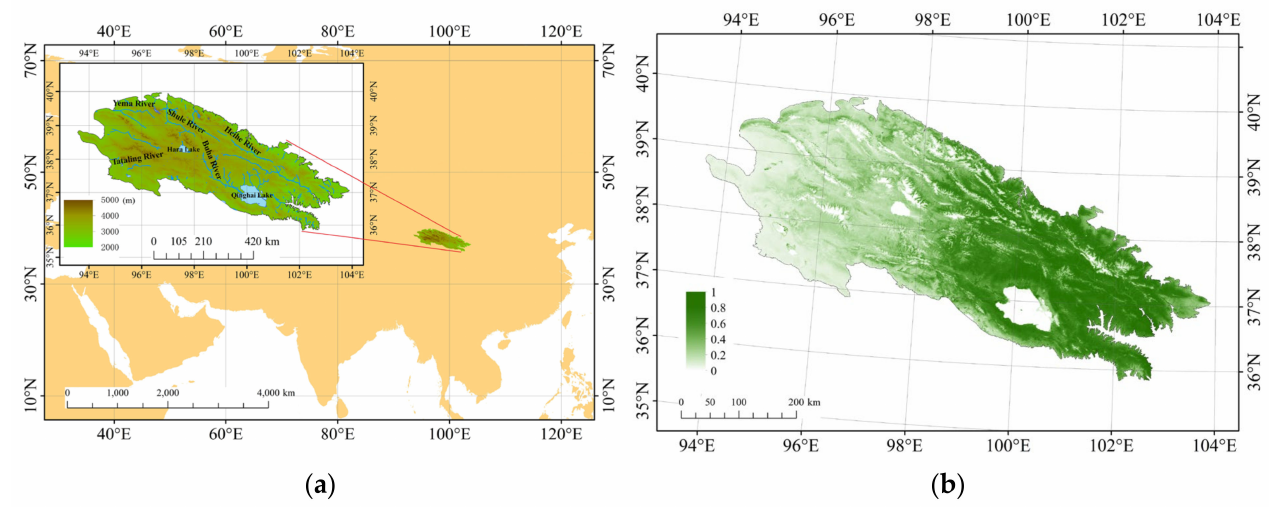
Figure 1. Geographical background of Qilian Mountains. ( a ) DEM, river network and location of study area; ( b ) mean of annual NDVI Maximum Value from 2000 to